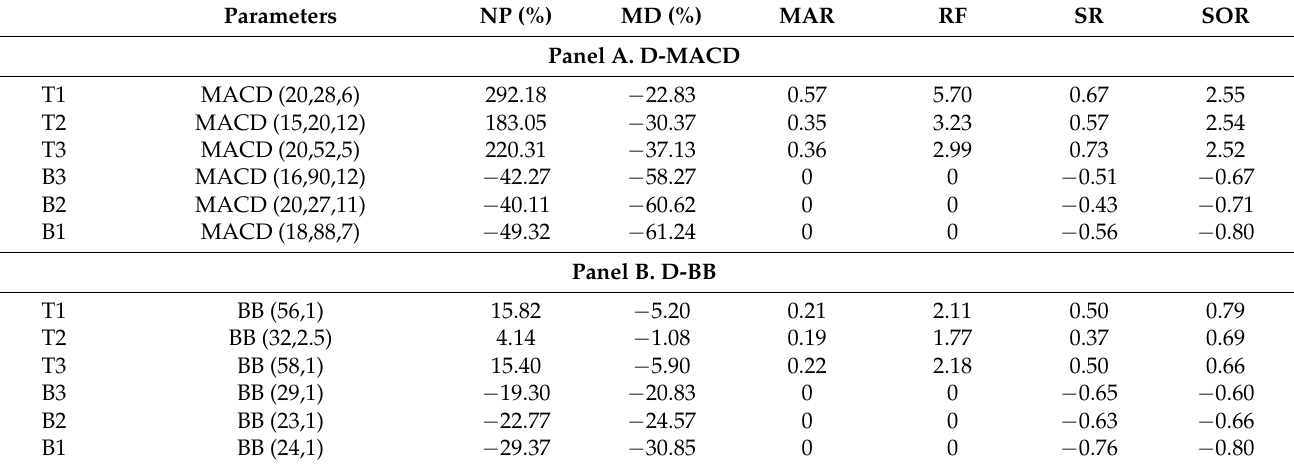
Table A2. Trading performance of hybrid fractal trading systems using different